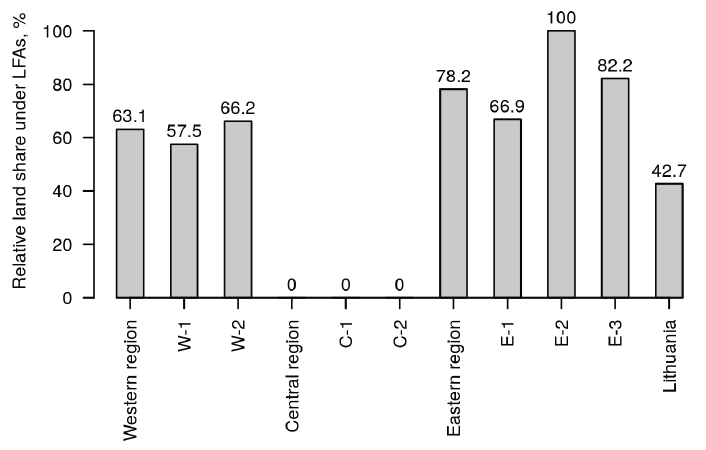
Fig. 2. LFAs in Lithuanian agro-ecological regions and zones